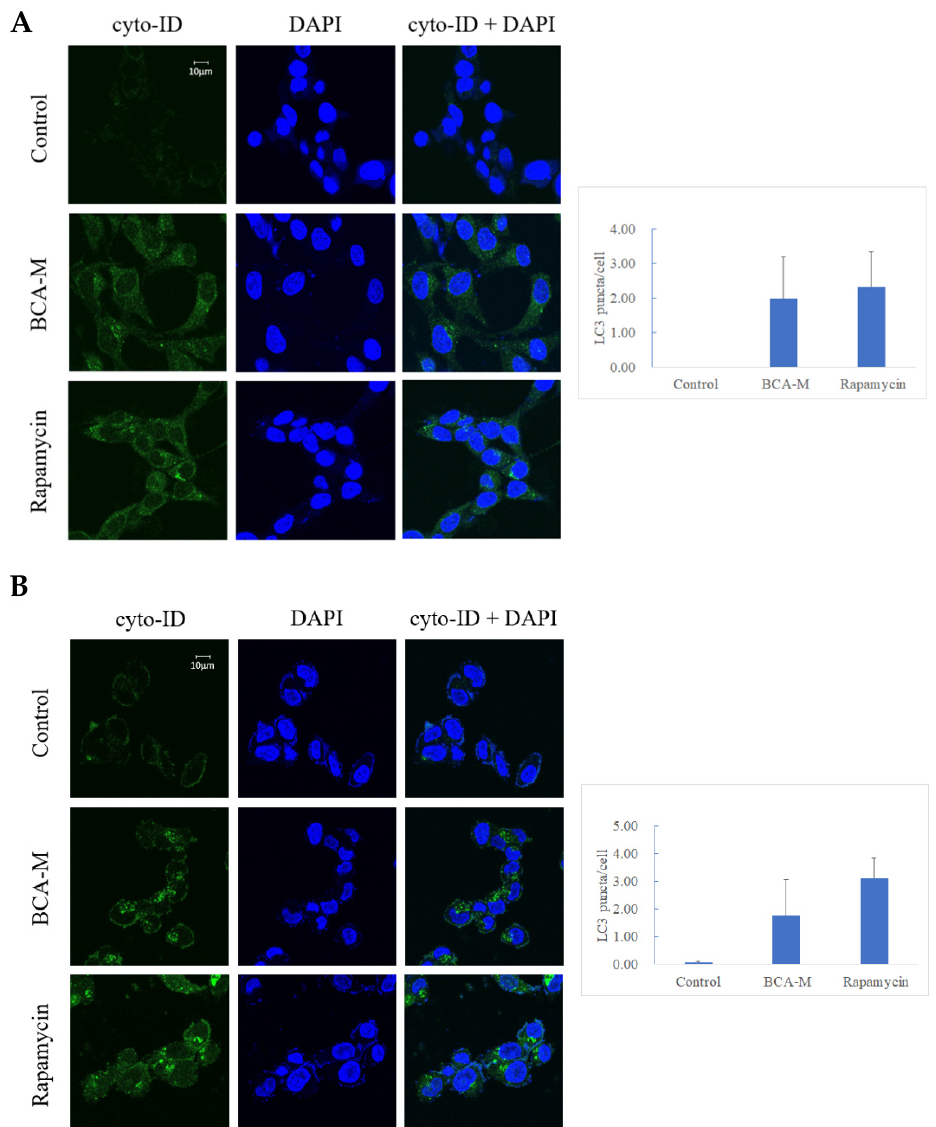
Figure 8. Fluorescent micrographs showing green punctate signals that represent autophagosome formation in ( A ) HeLa and ( B ) SiHa cells treated with BCA-M. Rapamycin was used as positive control. Quantification of the average number of LC3 puncta per cell was performed manually by counting obvious and large LC3 puncta ( n = 3).